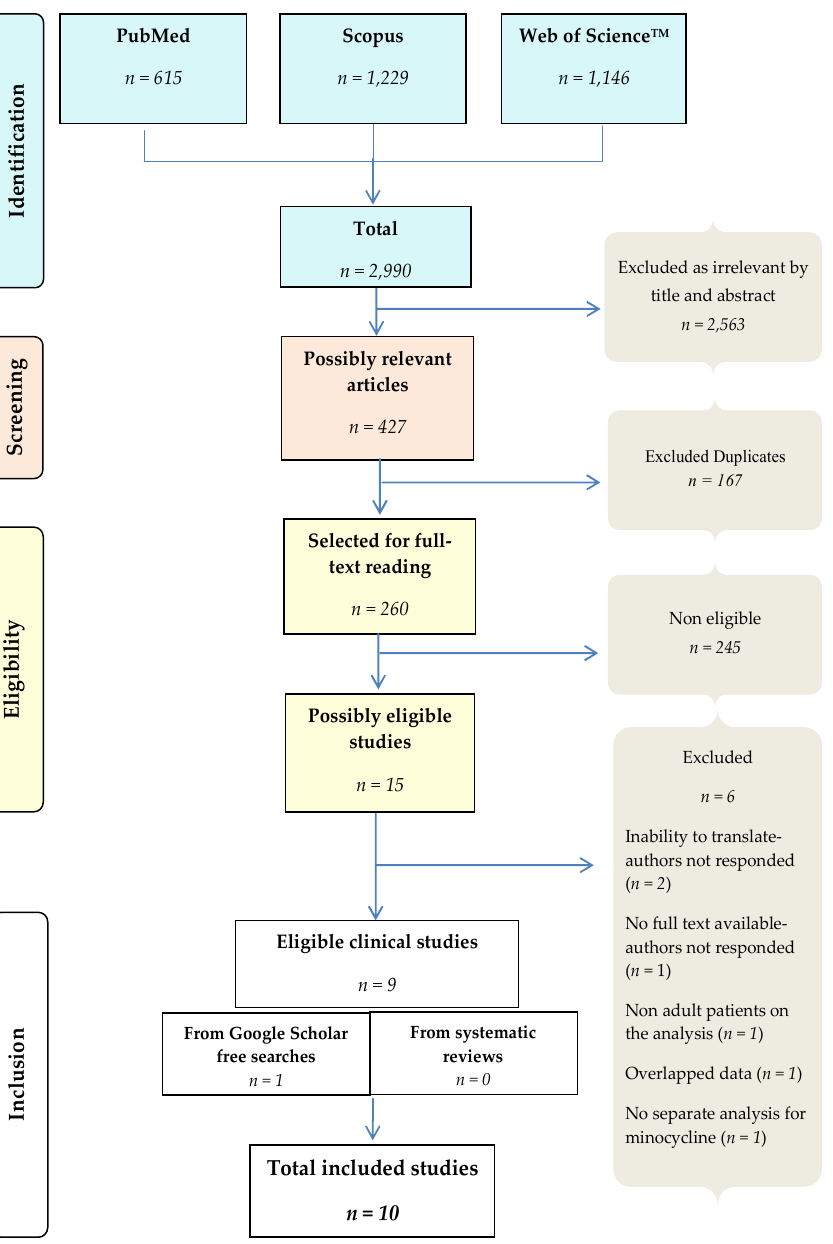
Figure 1. Systematic review flow Figure 1: Systematic Review Flowchart.